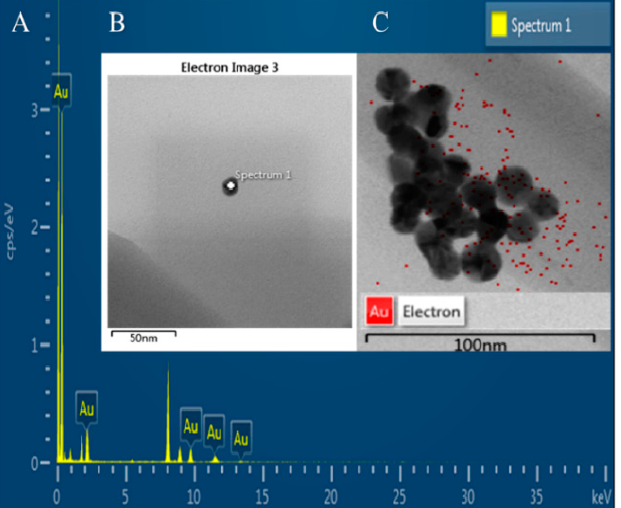
Figure 8. EDS mapping for point stage of the AuNP using SDD detector for TEM X-MaxN 80T ( A ) electron-spectrum-depicting energy-based elemental peak. ( B ) The spectrum for the point electron image at 50 nm scale. ( C ) EDS-layered image for electron mapping.